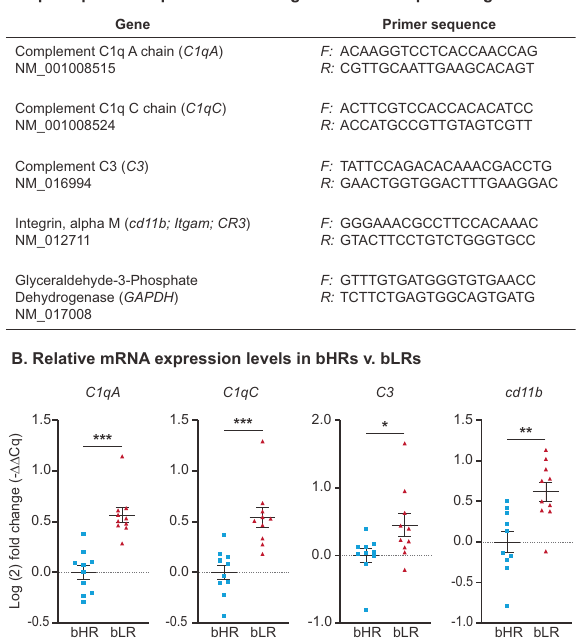
Fig. 1 Differential patterns of microglia-related gene expression in hippocampus following selective breeding. A Primer sequences of genes used for qPCR experiments. All primers were validated in- house, and expression levels of GAPDH (reference gene) were not signi fi cantly different between bHRs and bLRs (Supplemental Materials, Fig. S1). B Elevated hippocampal expression (Log(2) fold change) for several genes within the classical complement cascade was found in bLRs compared to bHRs. Data are expressed as mean ± SEM, with scatter plots overlaid to show individual data points. Welch ’ s t -tests: bHR v. bLR, ***C1qA: t 17.92 = 33.713, p <